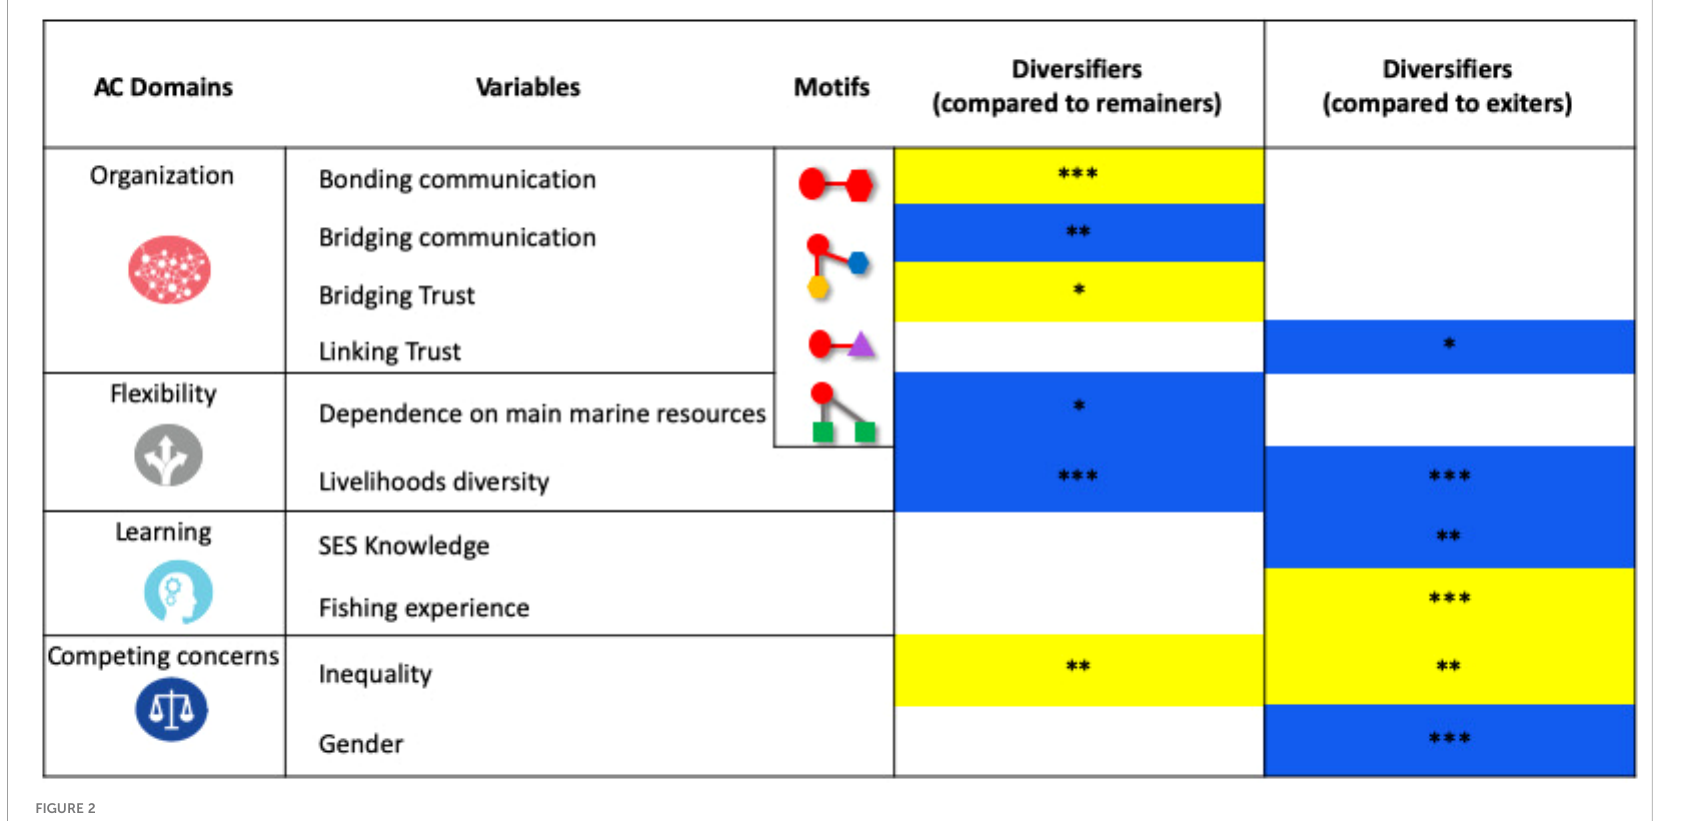
FIGURE 2 Relationships between the indicators of adaptive capacity (AC, organized by domain) that have a signi fi cant effect on the stated livelihood diversi fi cation behavior of fi shers facing hypothetical climate change scenarios. Signi fi cant relationships are displayed from the results of a multinomial multilevel logit mixed-effects model which modeled three categories of fi shers: diversi fi ers, remainers, and exiters. We were primarily interested in diversi fi ers, and thus diversi fi ers were set as the base category in order to be able to directly compare their characteristics to that of remainers and exiters. Colors indicate the type of relationship (yellow re fl ects a negative sign and blue captures a positive sign); presence of asterisks shows the signi fi cance level (* p-value < 0.1, ** p-value < 0.05, *** p- value < 0.01) and blank cells manifest non-signi fi cant effects. This fi gure aims to facilitate the visualization of the variables that contribute positively and/or negatively to diversi fi cation (the base category); thus, the sign of the relationships presented here are opposite the sign of the model results. Full model results are available in Table